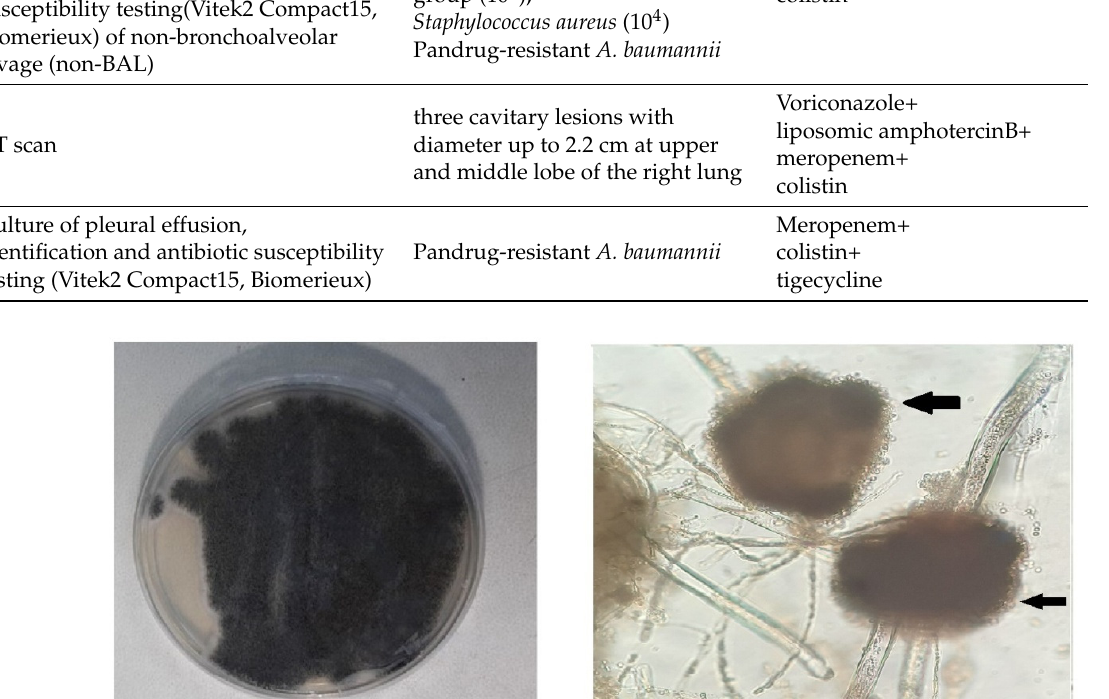
Table v. 10.0 valid from 4 February 2020) [23]. MIC values of ≥ 128 µ g/mL for fluconazole, 0.25 µ g/mL for itraconazole, 0.5 µ g/mL for voriconazole, 0.25 µ g/mL for